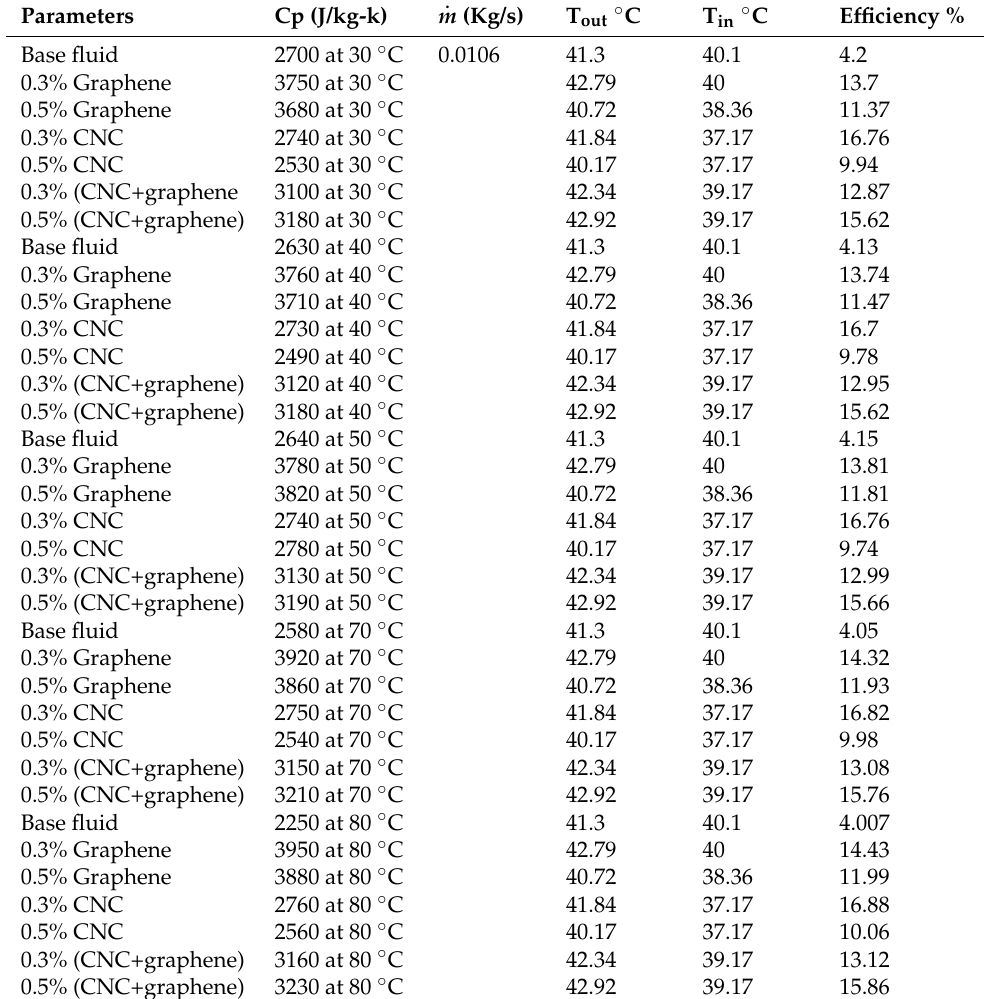
Table 2. Experimental data of flat plate solar collector where solar irradiation is 830 W/m 2